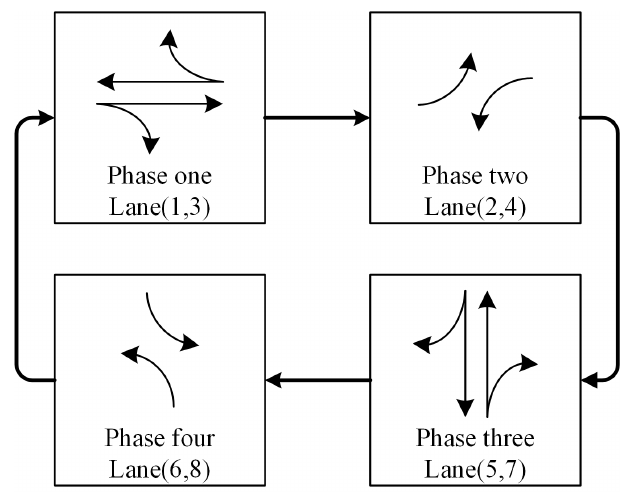
Figure 2. Four-phase transitions of the traffic signal control.